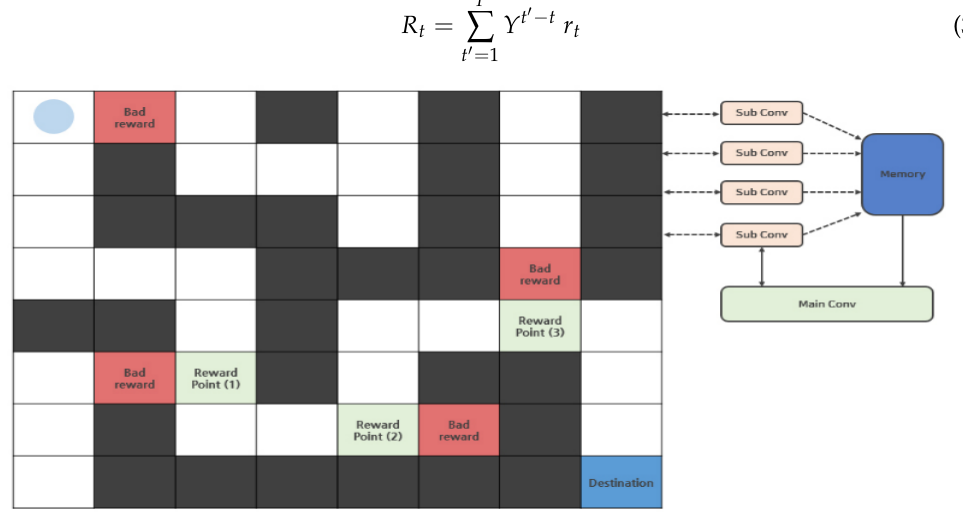
Figure 7. N-DQN’s reward acquisition policy.